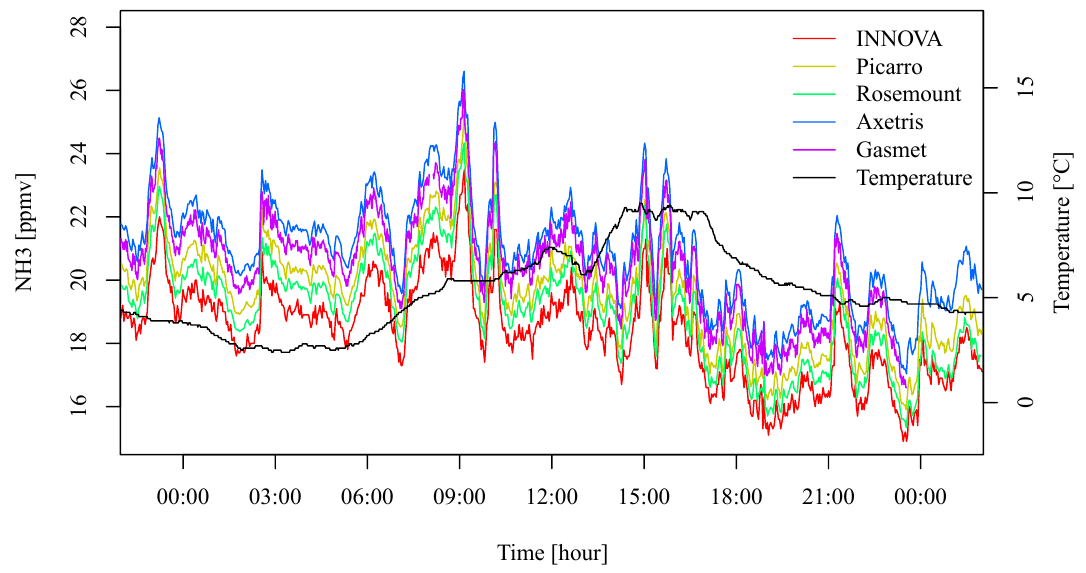
Figure 1. Time series of the measured ammonia (NH 3 ) by five gas analysers and the temperature in the pig barn. For better comparability and clarity, the data from Picarro, Rosemount and Axetris are downsampled to every 130 s based on moving averages. INNOVA and Gasmet are presented at 130 and 60 s measurement interval,